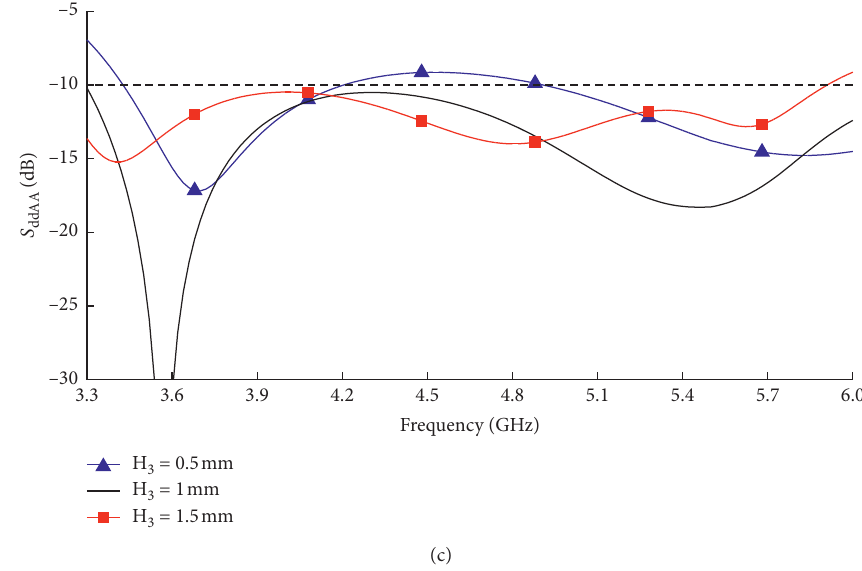
Figure 5: Parametric studies of the proposed antenna by changing the values of (a) W